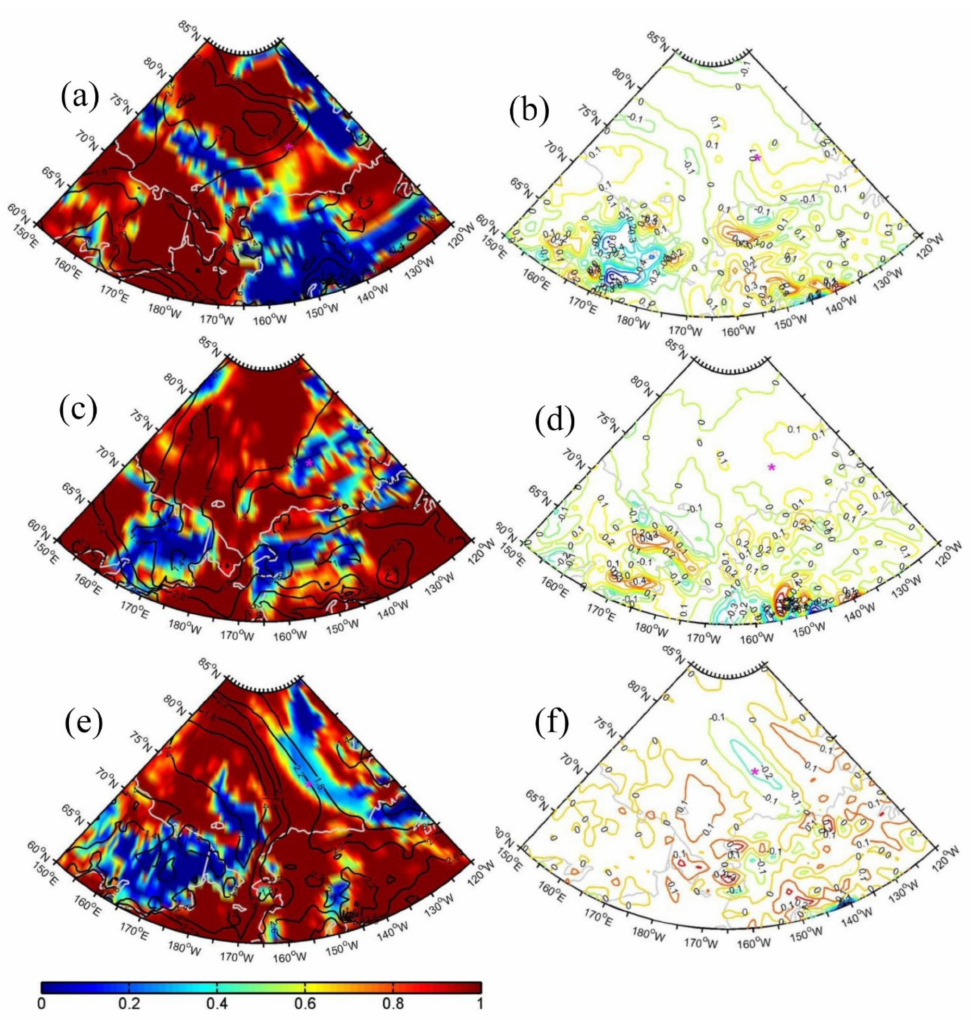
Figure 5. The same as in Figure 4 except for downward surface longwave radiation (106 W m − 2 ) (contour) and total cloud cover (shading) ( a , c , e ) and vertical velocity (Pa s − 1 ; downward velocity is positive) at 850 hPa ( b , d , f ).